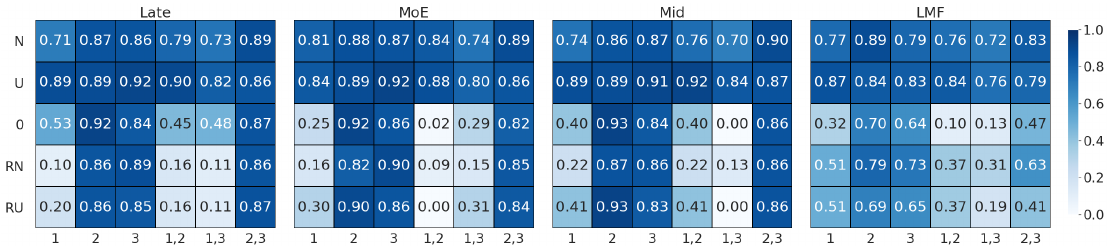
Figure 6. The AUC-ROC reported for the multi-label classification task using the PHAC-2 dataset. The leading modality is visible, but the correlations between modalities also affect